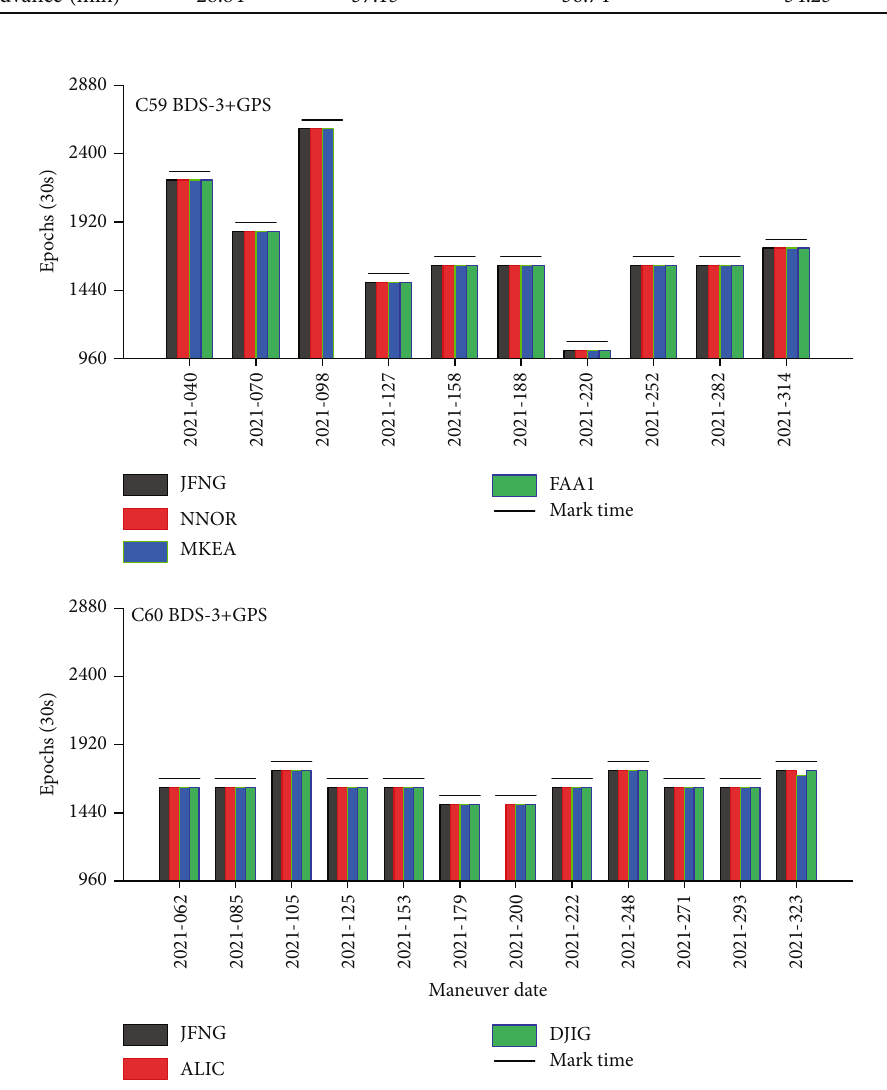
Figure 14: Comparison of detection results for C59 and C60 orbit maneuvering end times by di ff erent stations.